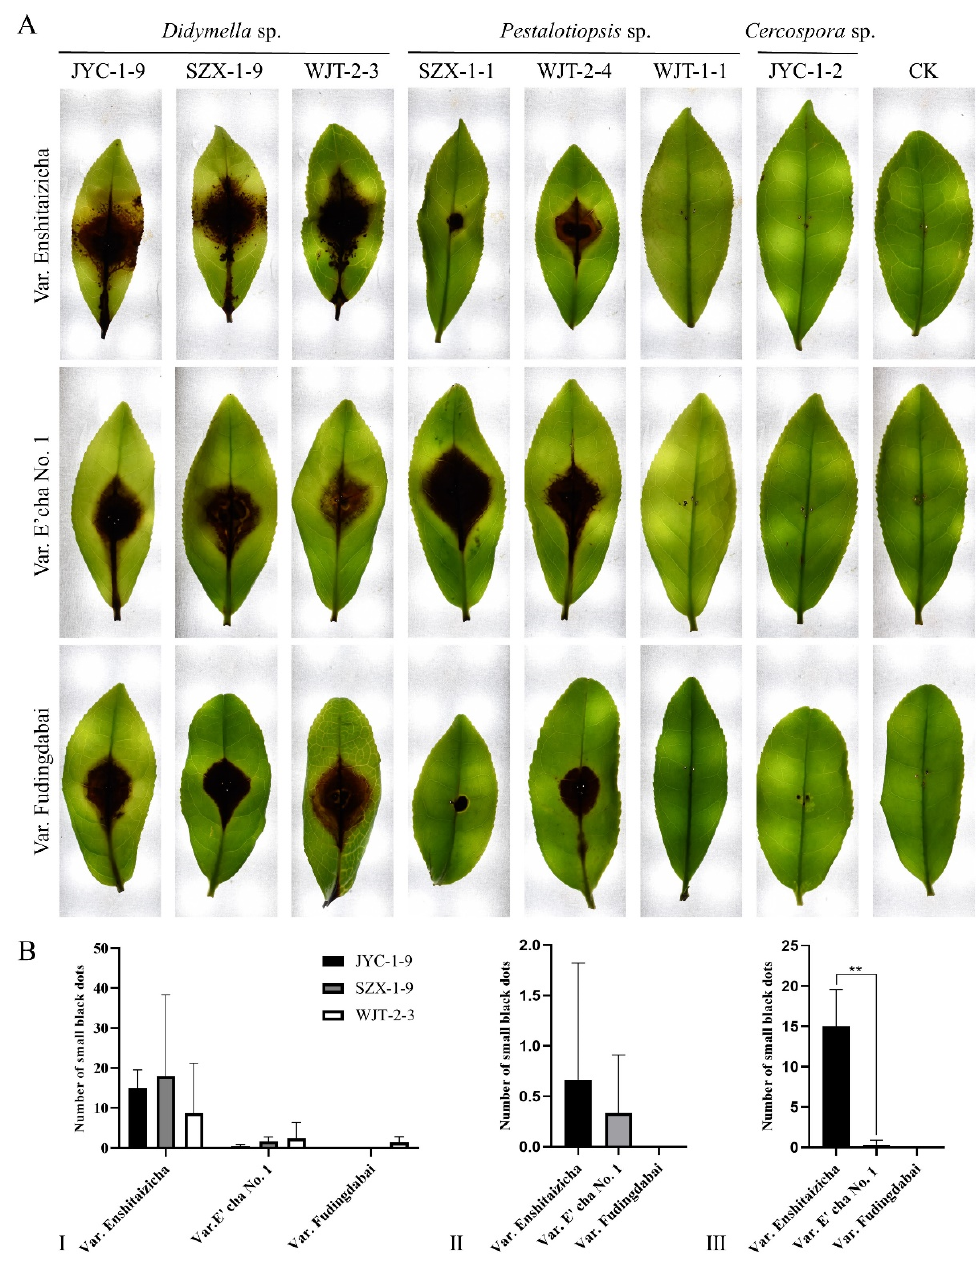
Figure 2. Pathogenicity analysis of Didymella , Pestalotiopsis, and Cercospora isolates on the tea leaves of vars. Enshitaizicha, E’cha No. 1, and Fudingdabai. ( A ) The representative leaf symptoms of the varieties induced by the involved isolates, indicated on the left and on the top of the panels, respectively. The pathogenicity test was conducted at 25 ◦ C and 90% relative humidity and photographed at 5 days post-inoculation (dpi). ( B ) The small brown spot numbers on the leaves induced by the Didymella (I) and Pestalotiopsis isolates (II) and the statistics analysis for the treatment of Didymella JYC-1-9 (III). The data were analyzed by SPSS Statistics 19.0 (International Business Machines Corporation, Armonk, NY, USA) using one-way ANOVA, and the mean values were compared with a Tukey test, p = 0.01. The asterisks (**) on error bars indicate significant differences at p = 0.01. Fungal reisolation from the diseased tissues neighboring the asymptomatic ones con- firmed that the subisolates matched the inoculated ones with regards to their morpholo-